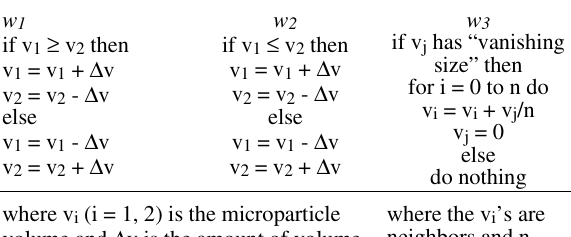
Table 1. The three functions acting upon the set of microparticles. w 1 if v 1 ≥ v 2 then